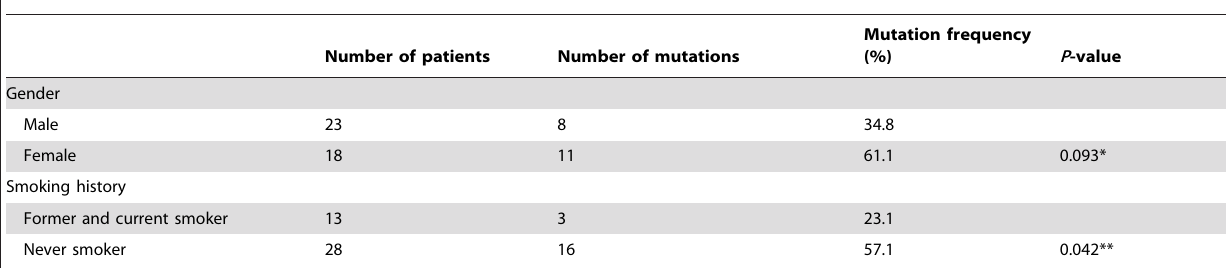
Table 2. EGFR mutations in MPTT samples.